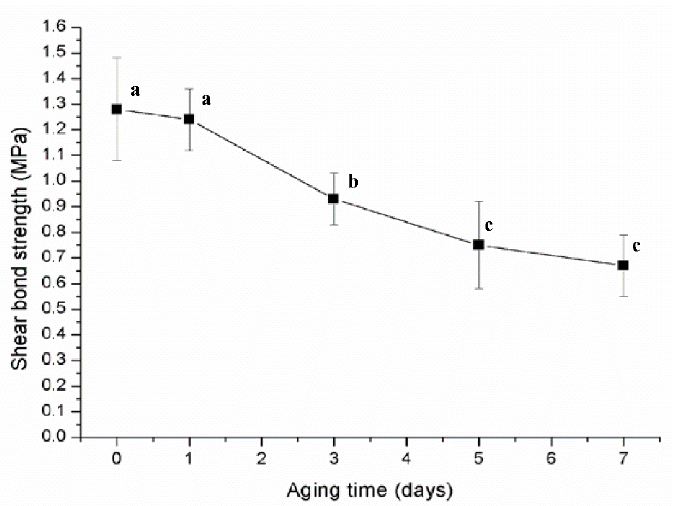
Figure 7. Shear bond strength between non-thermal atmospheric pressure nitrogen plasma-treated epoxy resin and fiber post with respect to the time passed after the treatment (different lower case alphabet letter indicates statistical difference, p < 0.05).